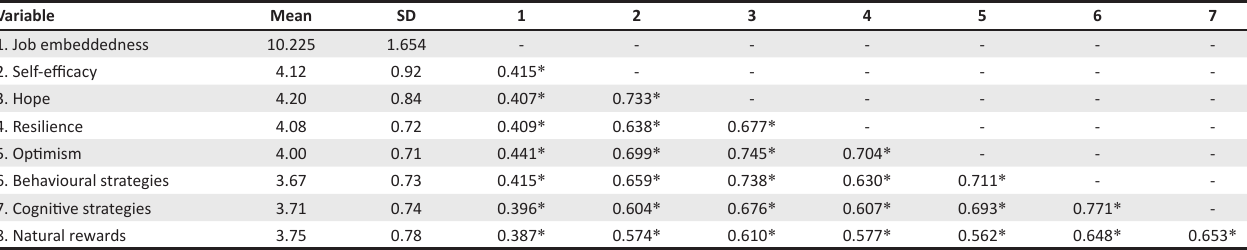
TABLE 2: Descriptive statistics, correlations between the variables ( N = 303). Variable